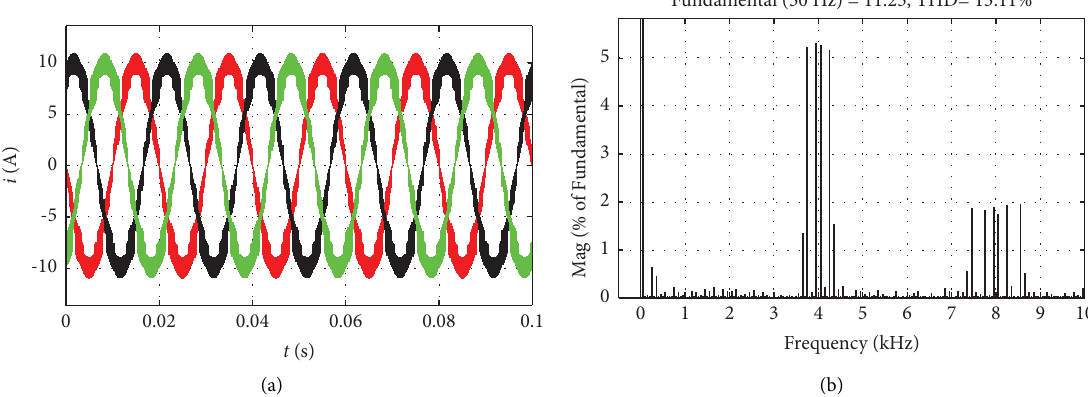
Figure 8: Waveform of the grid-connected current without a flter and its frequency spectrum. (a) Waveform of the grid-connected current and (b) frequency spectrum of the grid-connected current.